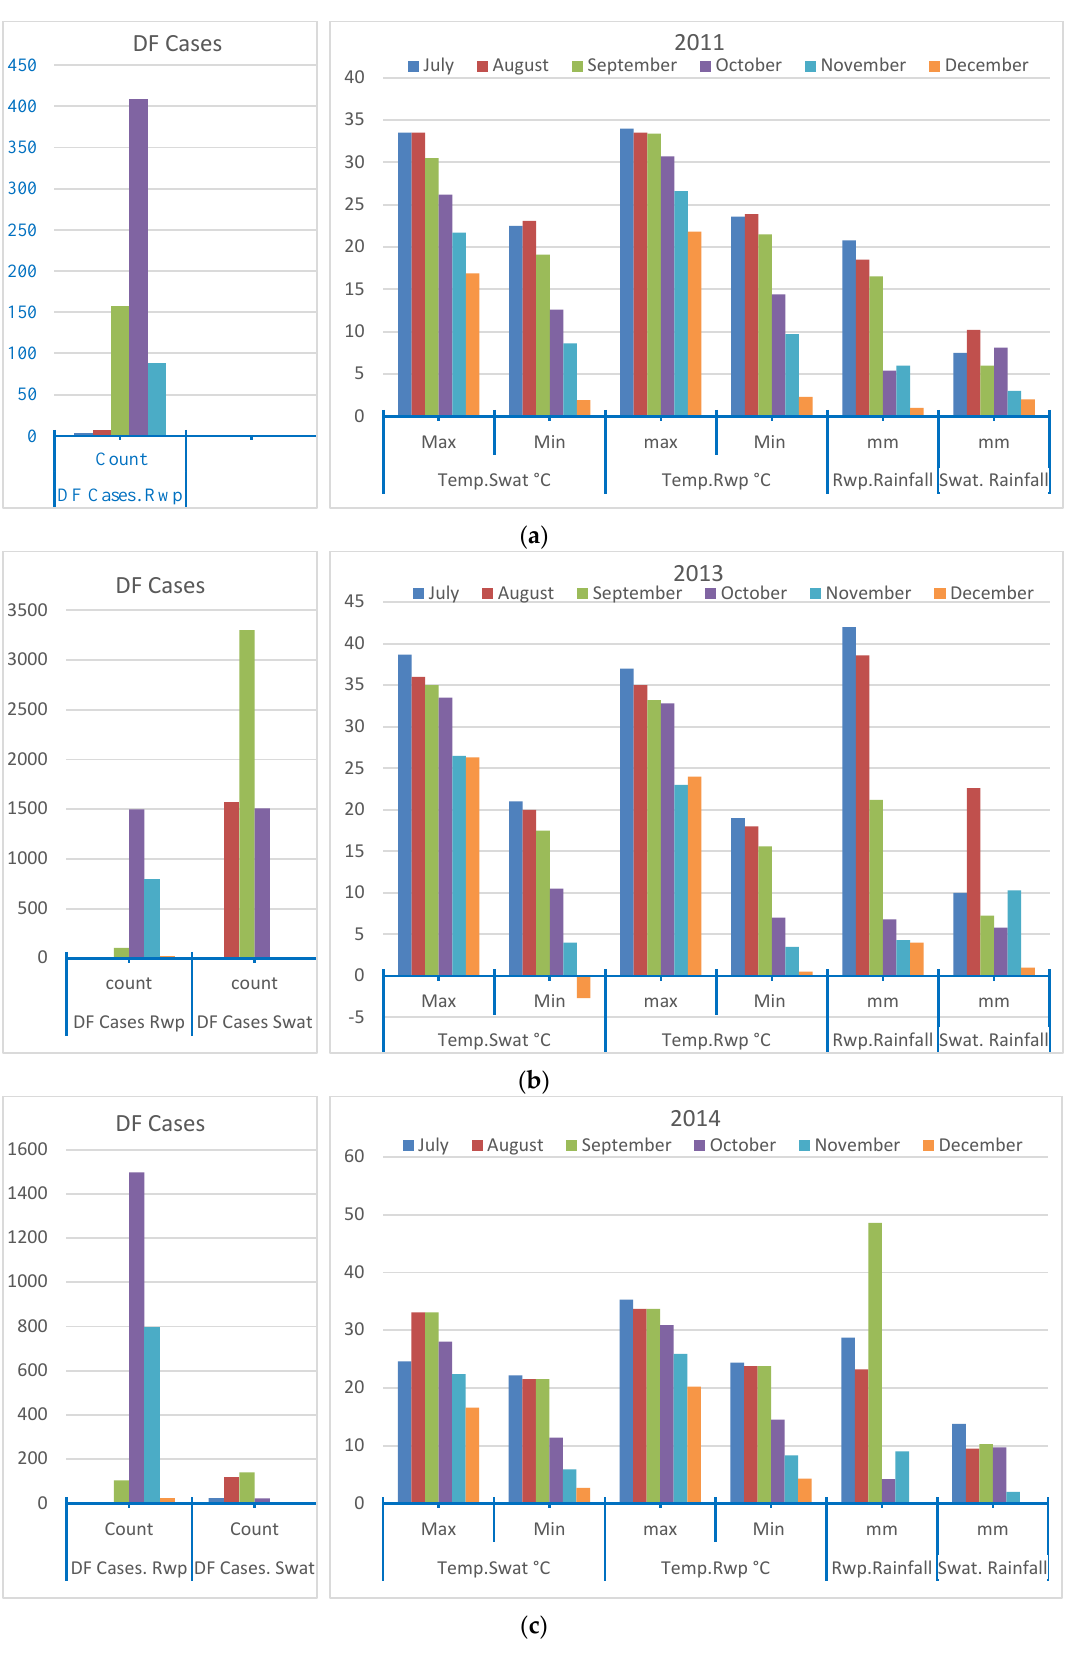
Figure 3. Climate indices for Rawalpindi-Islamabad and Swat vs. DF cases for year 2011, 2013 and 2014. ( a ) 2011; ( b ) 2013; ( c ) 2014.